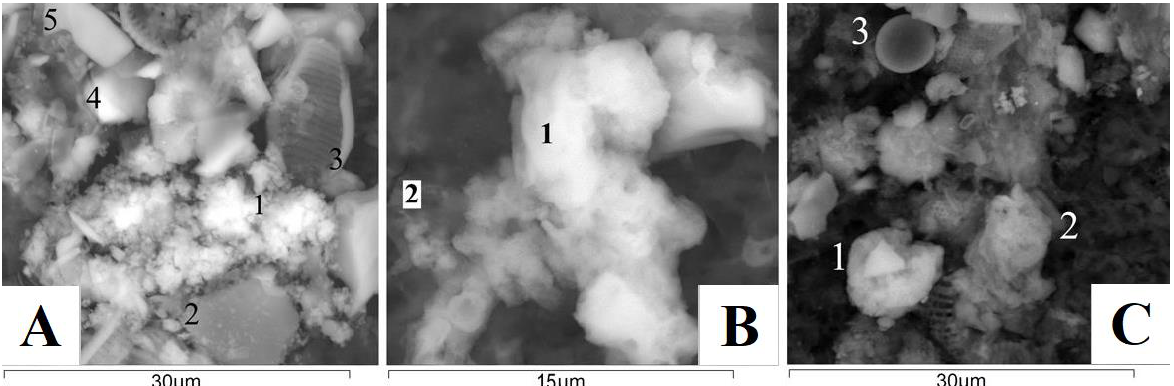
Figure 8. Micrographs obtained using SEM ofsamples of river suspended matter on filters taken in the Vytegra River ( A ), Vodla River ( B ) and Kumsa River ( C ): ( A ) 1 — fine-fiber algae aggregate (amorphous silica), 2 — shells and biodetrite of diatoms and 3 — fine-grained aggregate terrigenous minerals (quartz, plagioclase (10 – 30% anorthite), albite and Fe-Mn illite); ( B ) 1 — spherical hollow aggregates of spores, 2 — shells and biodetrite of diatoms and 3 — scaly aggregates of muscovite; ( C ) 1 — fine-fibrous aggregate of algae (amorphous silica).